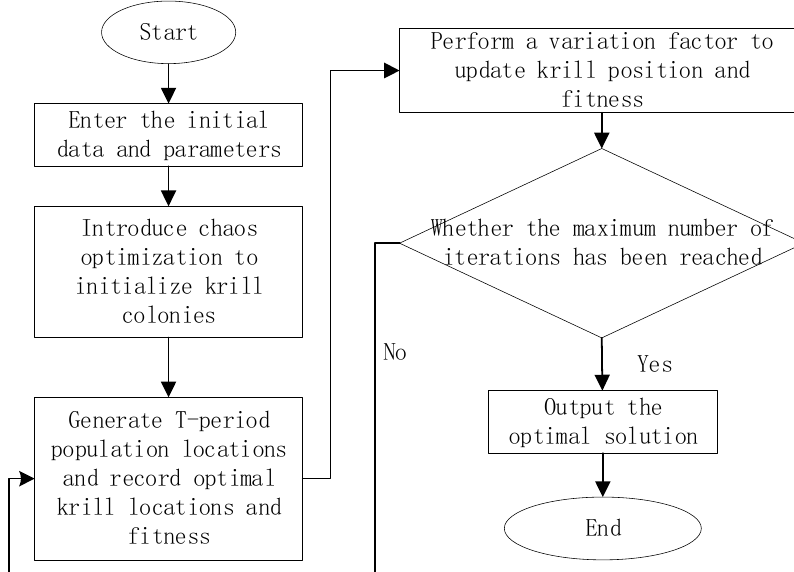
Figure 2. Flow chart of krill swarm algorithm based on chaos optimization.